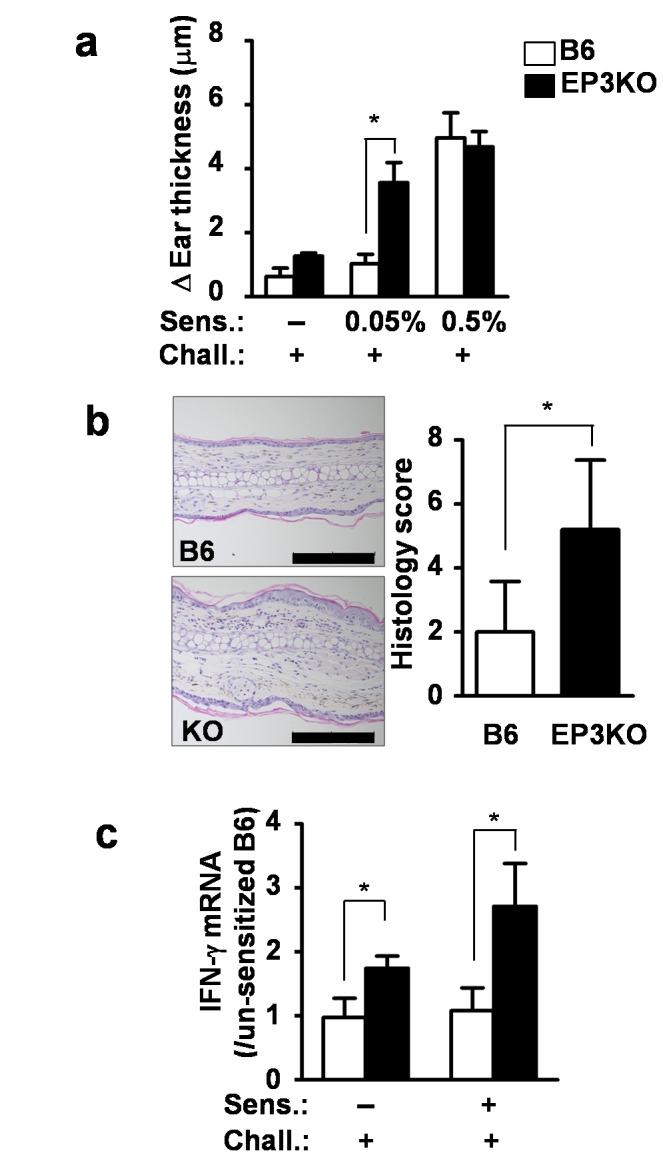
Enhancement of cutaneous immune response in EP3KO mice.(a) B6 and EP3KO mice (n=5 per group) were sensitized with 0 (un-sensitized), 0.05 or 0.5%-DNFB and the ear swelling was measured 24 hours after challenge with 0.3%-DNFB. (b) Hematoxylin-eosin staining of ears after the challenge. Scale bar indicates 200 µm. The total histology score was calculated as the sum of four elements (inflammation, neutrophils, edema and epithelial hyperplasia). (c) IFN-γ mRNA in the draining lymph nodes of the un-sensitized and 0.05%-DNFB-sensitized mice. Draining lymph nodes were collected after the measurement of ear swelling (n=5). Each data represents the mean + SD. *p<0.05. sens, sensitization; chall, challenge.